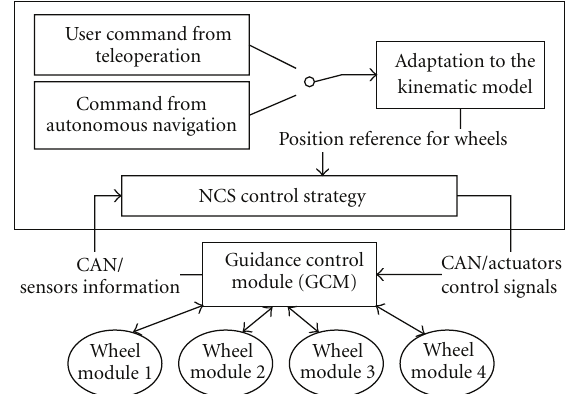
Figure 5: NCS architecture proposed for the Agribot Guidance